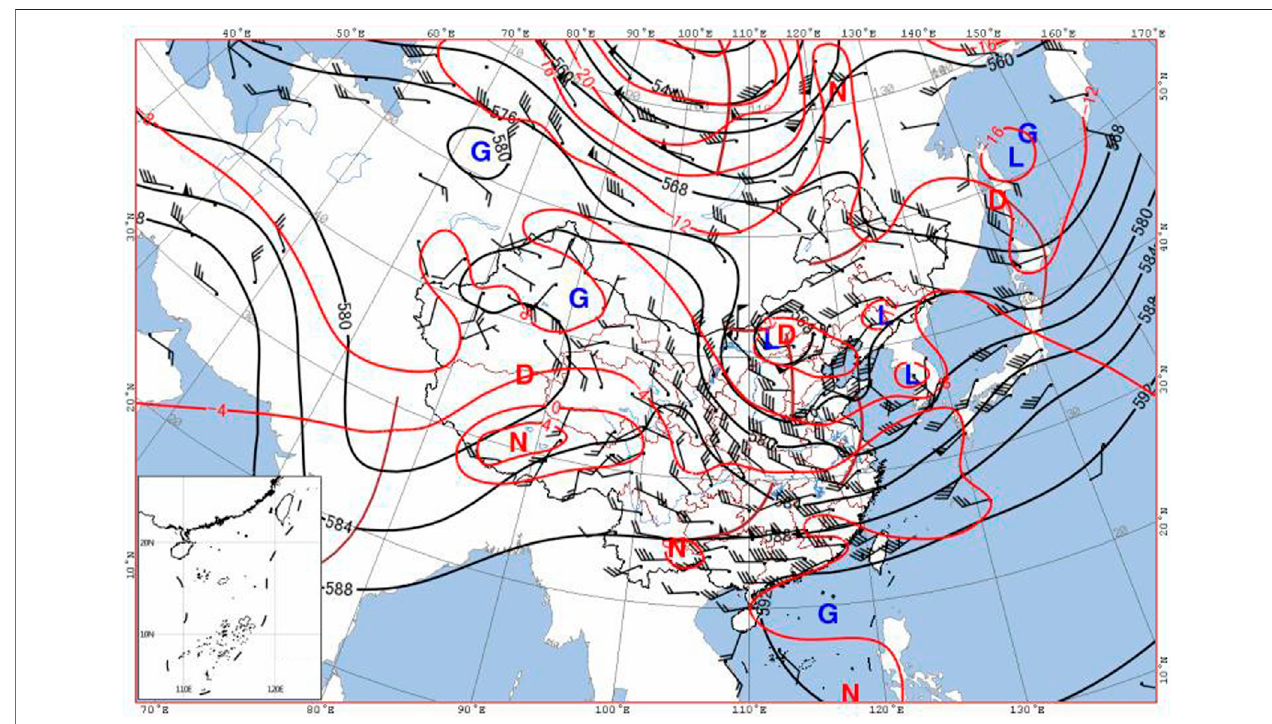
FIGURE 1 | Wind fi eld, height fi eld (black isolines) and temperature fi eld (red isolines) at 500 hPa at 20:00 on June 17, 2010. (G. D, N, and L are high pressure center, low pressure center, warm center, and cold center in turn).